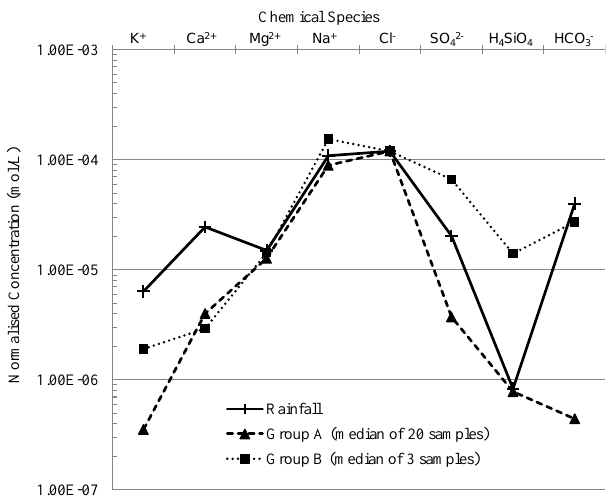
Figure 5. Schoeller plot of sampled waters normalised to local rainfall Cl − (see Sect. 4.2).